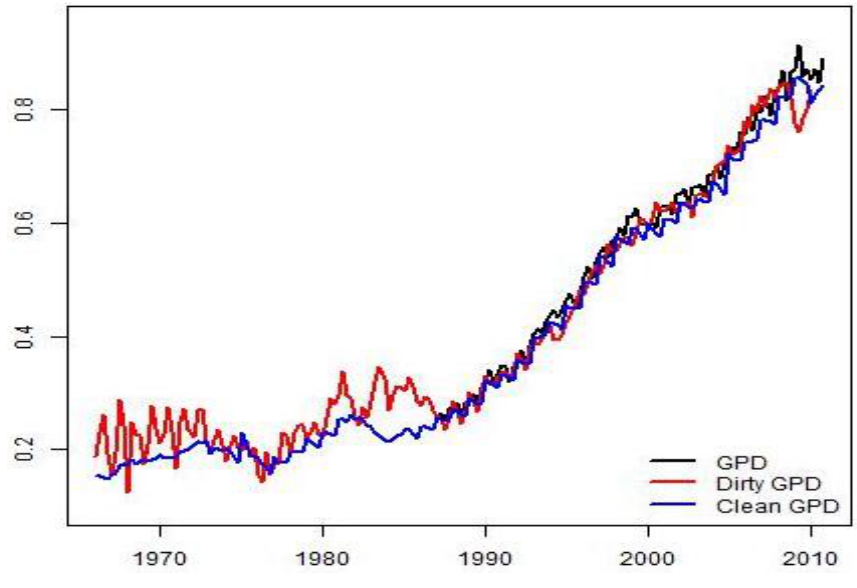
Figure 4. Real, dirty, and clean